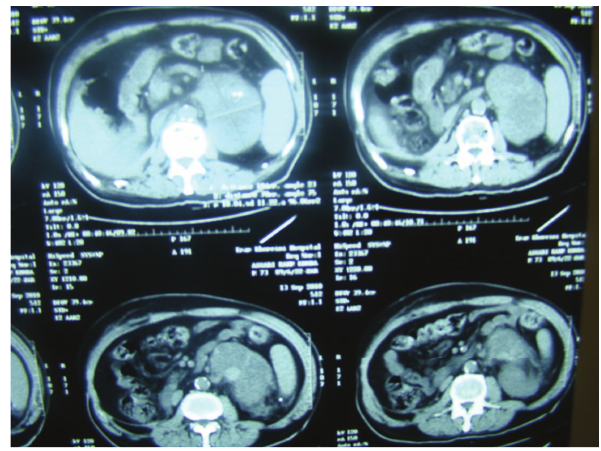
Figure 1: Contrast enhanced abdominal CT scan revealing the first tumor of the patient, right RCC.